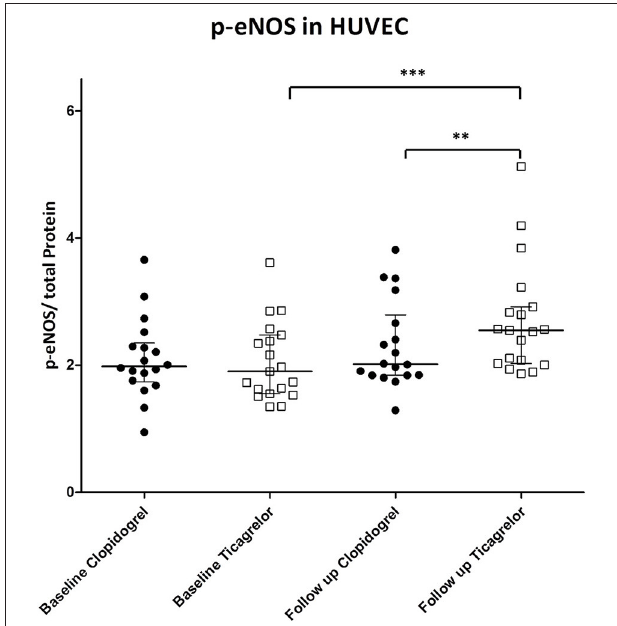
FIGURE 3 | p-eNOS in HUVEC treated with patient’s sera at baseline and after 1 month of treatment. Black circle: patient randomized to clopidogrel. p-eNOS levels are expressed as OD at 450nm. White square: patient randomized to ticagrelor. ** P < 0.01; *** P < 0.001.